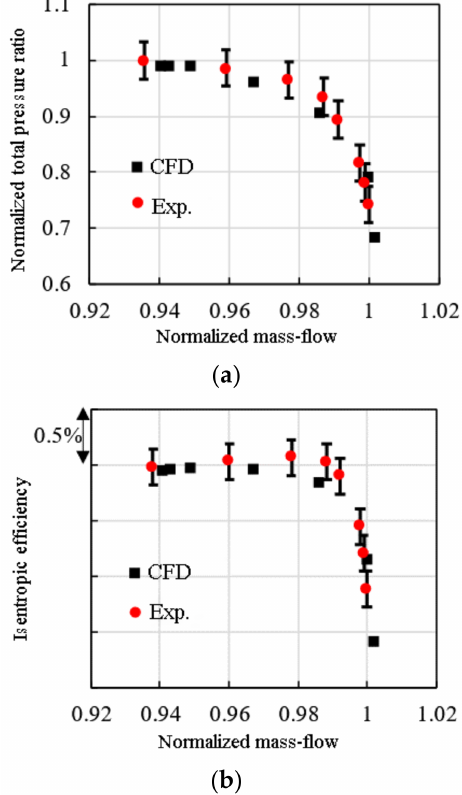
Figure 5. Comparison of overall performance at design rotational speed between experimental measurement and numerical simulation. ( a ) Total pressure ratio versus mass flow, ( b ) Isentropic efficiency versus mass